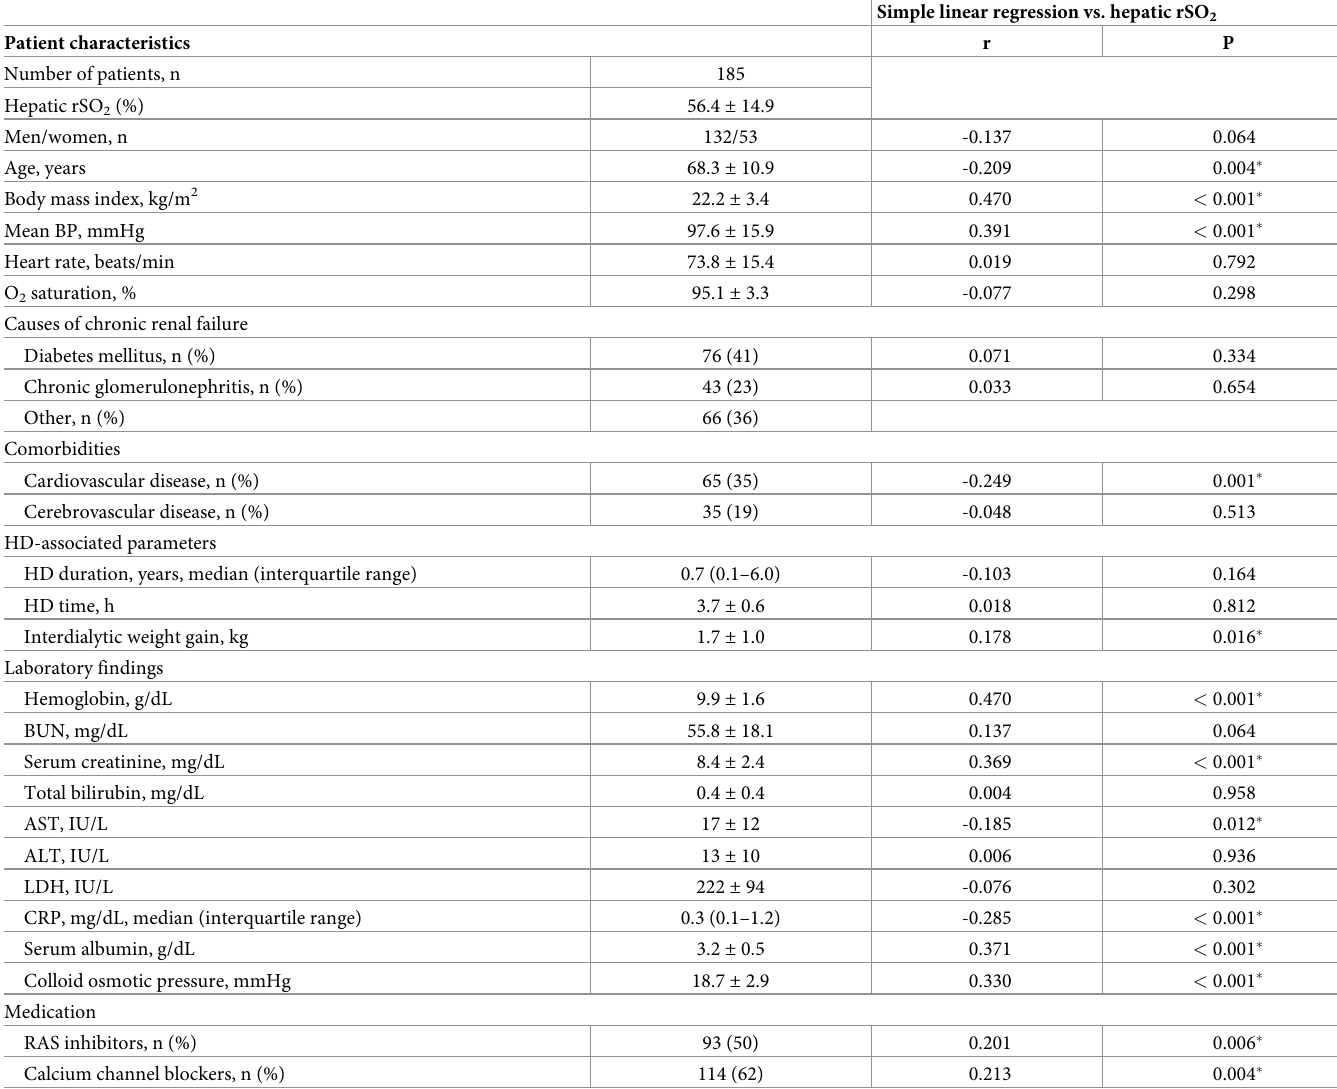
Table 1. Characteristics of patients undergoing hemodialysis and correlations between hepatic rSO 2 and clinical parameters.